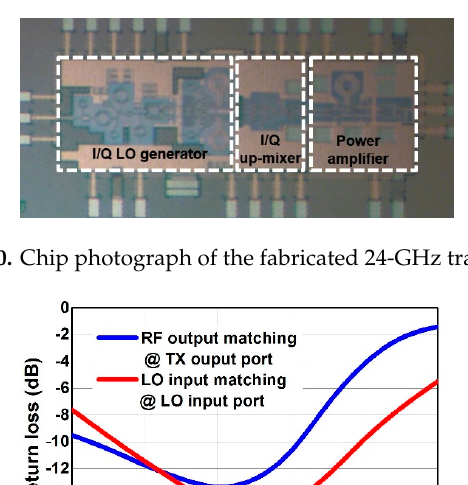
Table 1. Performance comparison with CMOS mm-wave